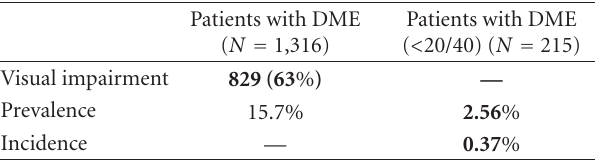
Table 3: Incidence and